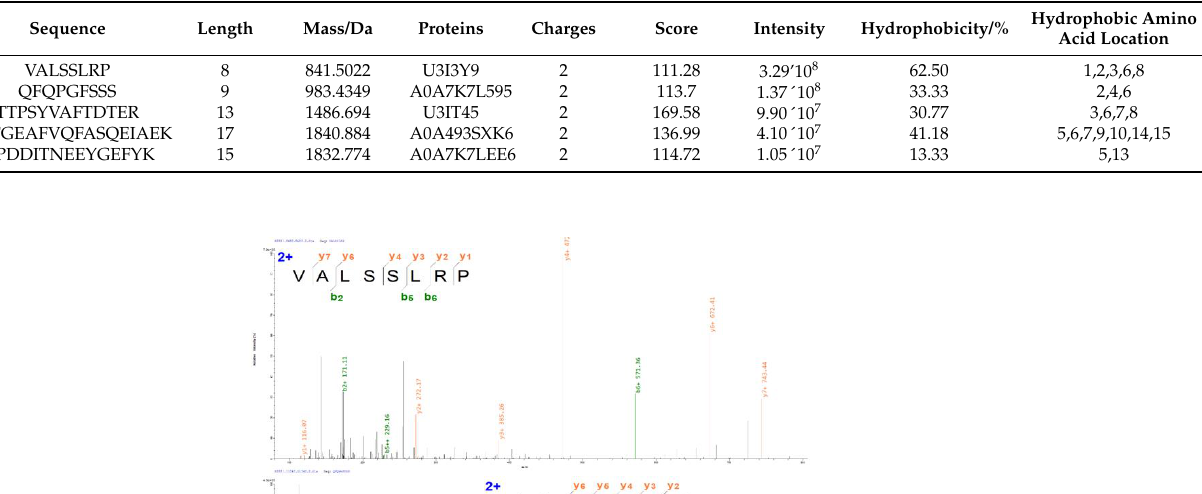
Table 1. Peptides with ACE inhibitory activity in Muscovy duck plasma hydrolysis.